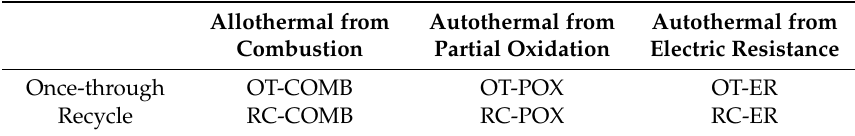
Table 1. Summary of plant configurations considered in this work. Configurations are identified by two-part acronyms, where first part (once-through: OT or recycle: RC) identifies the placement of the syngas preparation step in the process chain, and the latter part the heat supply method (allothermal from combustion: COMB, partial oxidation: POX or electric resistance: ER). Allothermal from Autothermal from Autothermal Combustion Partial Oxidation